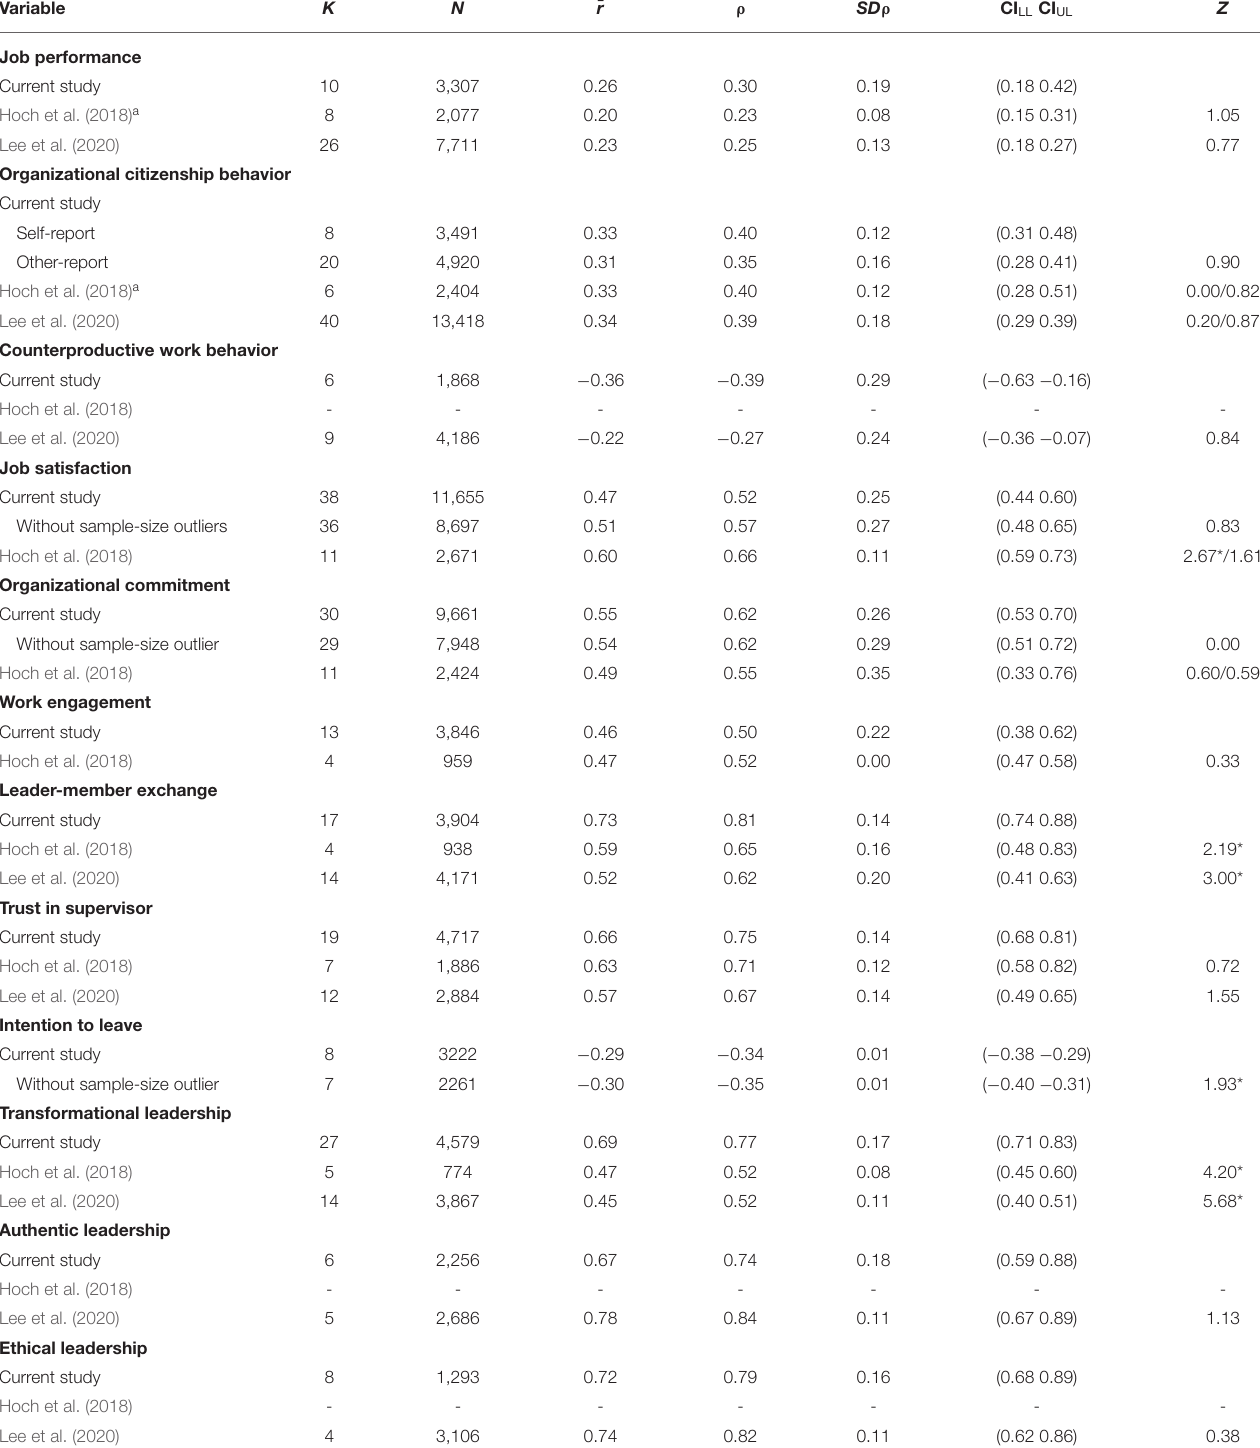
TABLE 3 | Comparison of current and prior meta-analytic results for servant leadership.